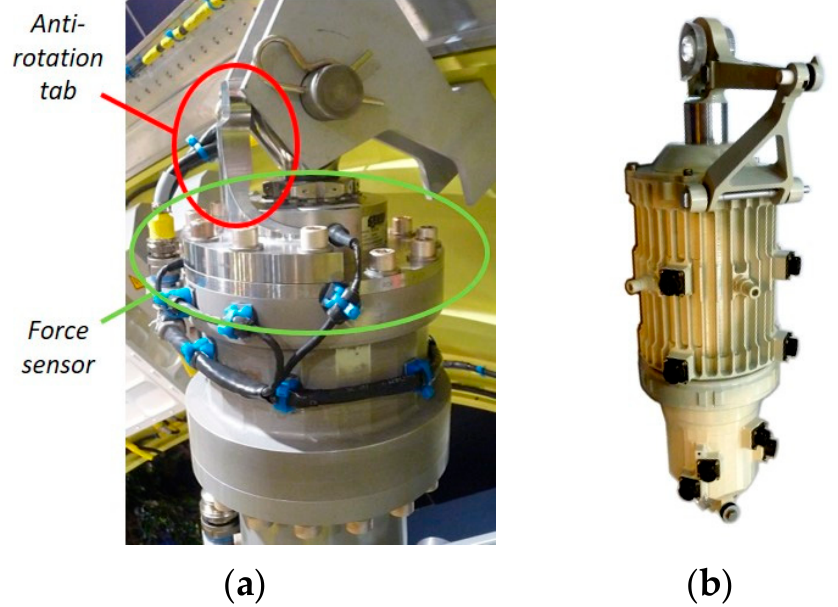
Figure 15. Examples of means to produce reaction torques in linear EMAs: ( a ) Anti rotation tab (Ariane V first stage TVC, in service); ( b ) Compass (Helicopter main rotor EMA, HEAT project) [32].